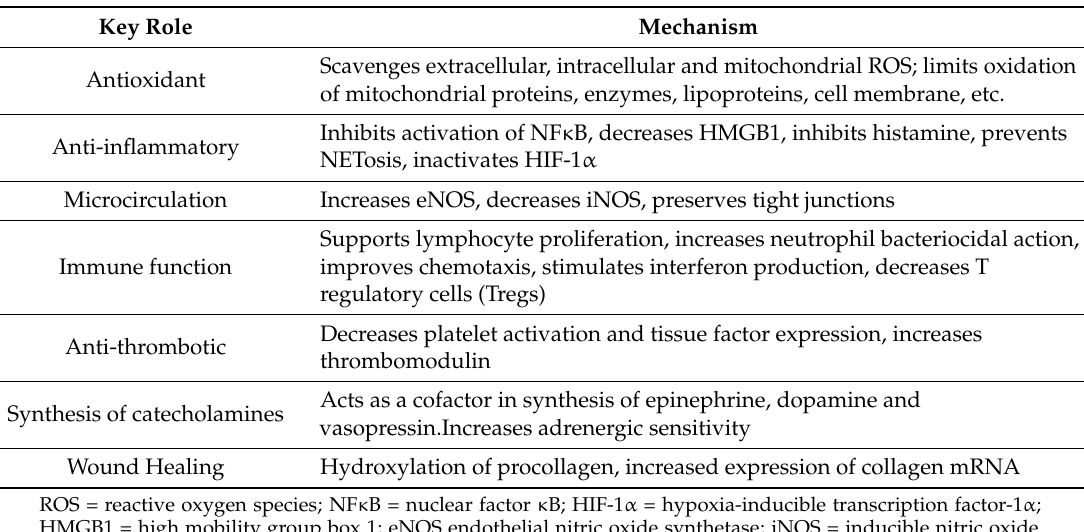
Table 1. Summary of key roles of Vitamin C in